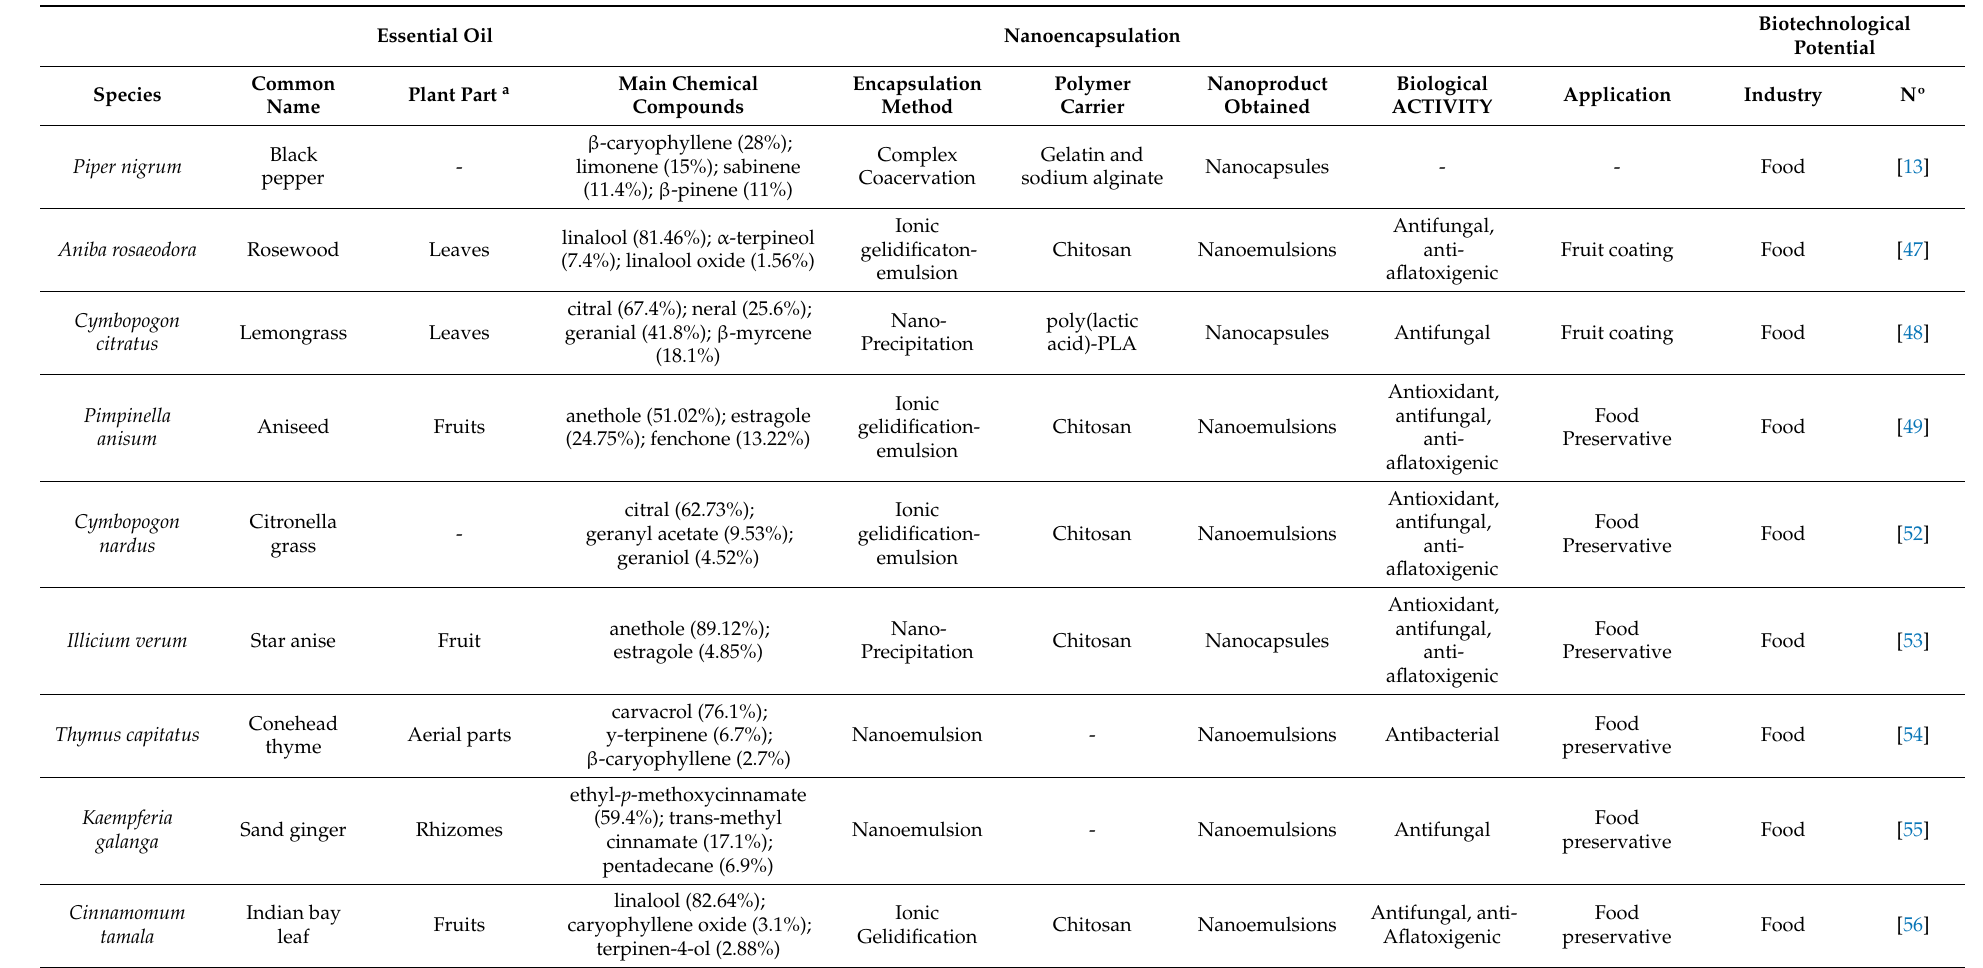
Table 1. Nanoencapsulated essential oils and their biotechnological